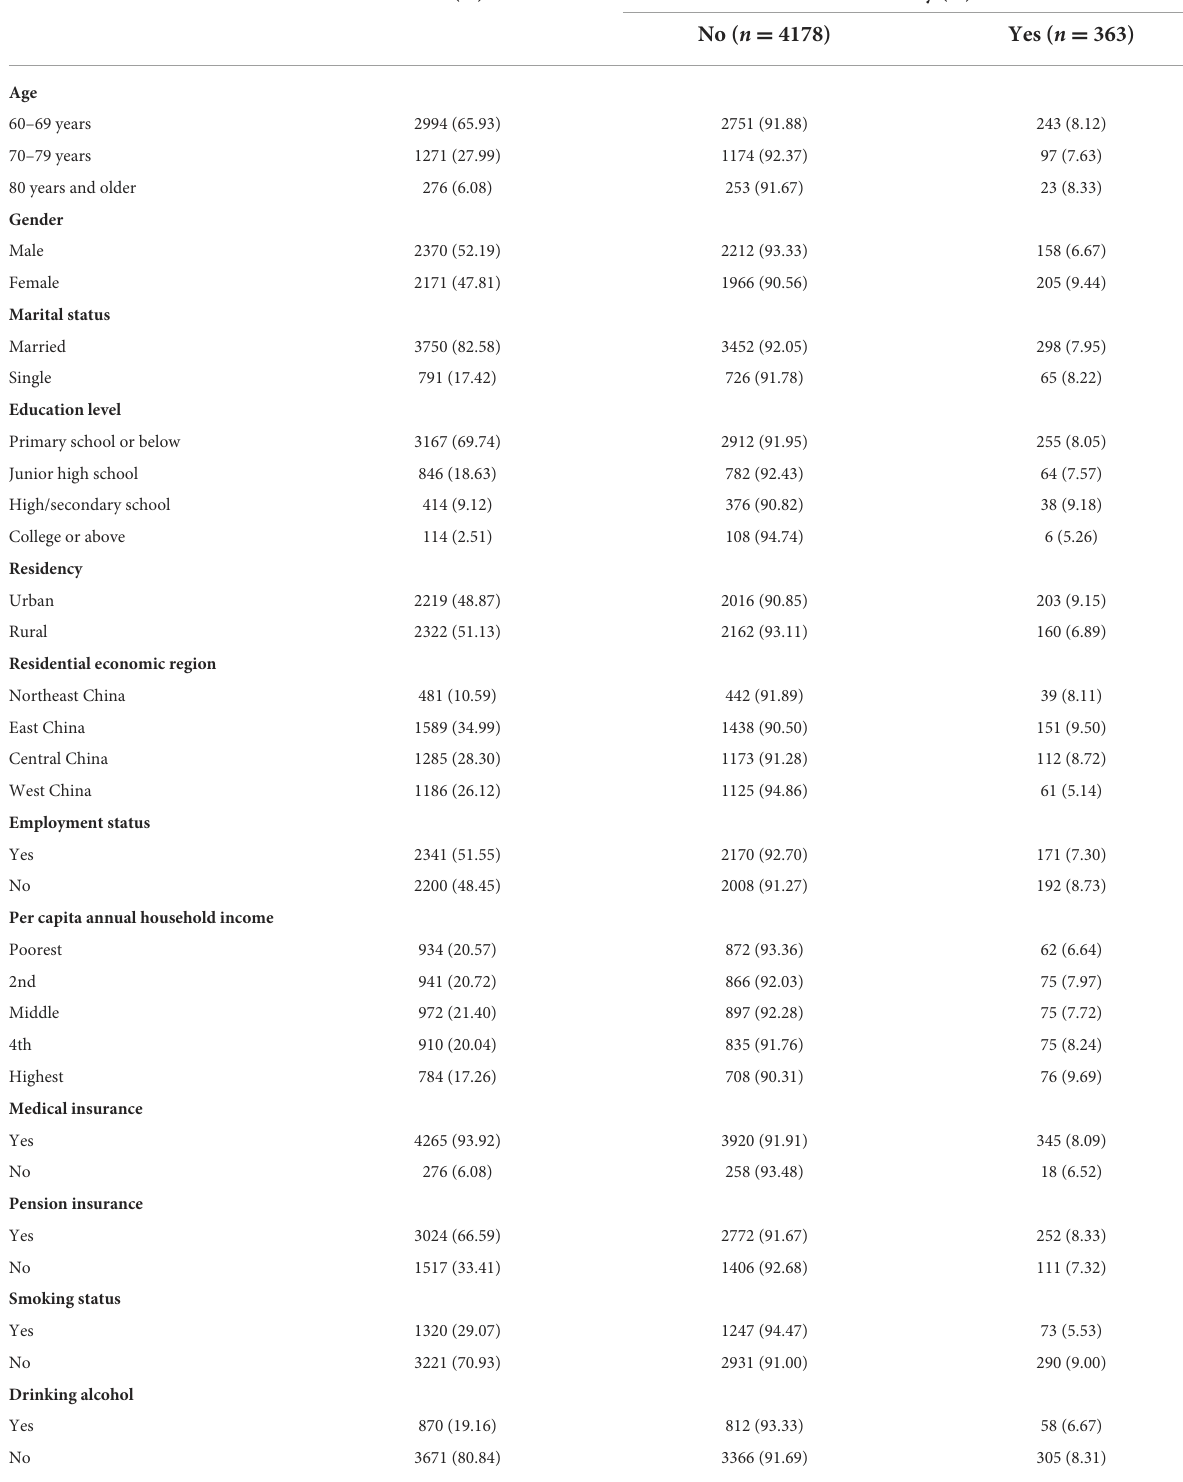
TABLE 1 Descriptive statistics for variables ( N =